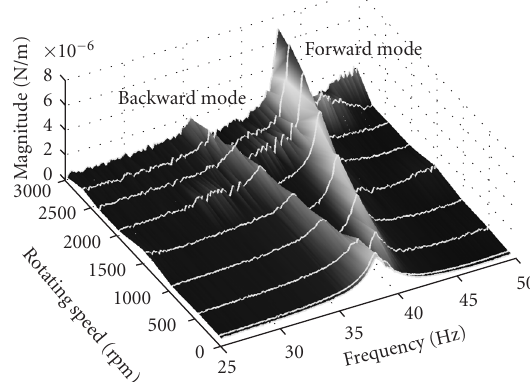
Figure 7: The Campbell diagram and the evolution of the first for- ward and backward whirl modes.